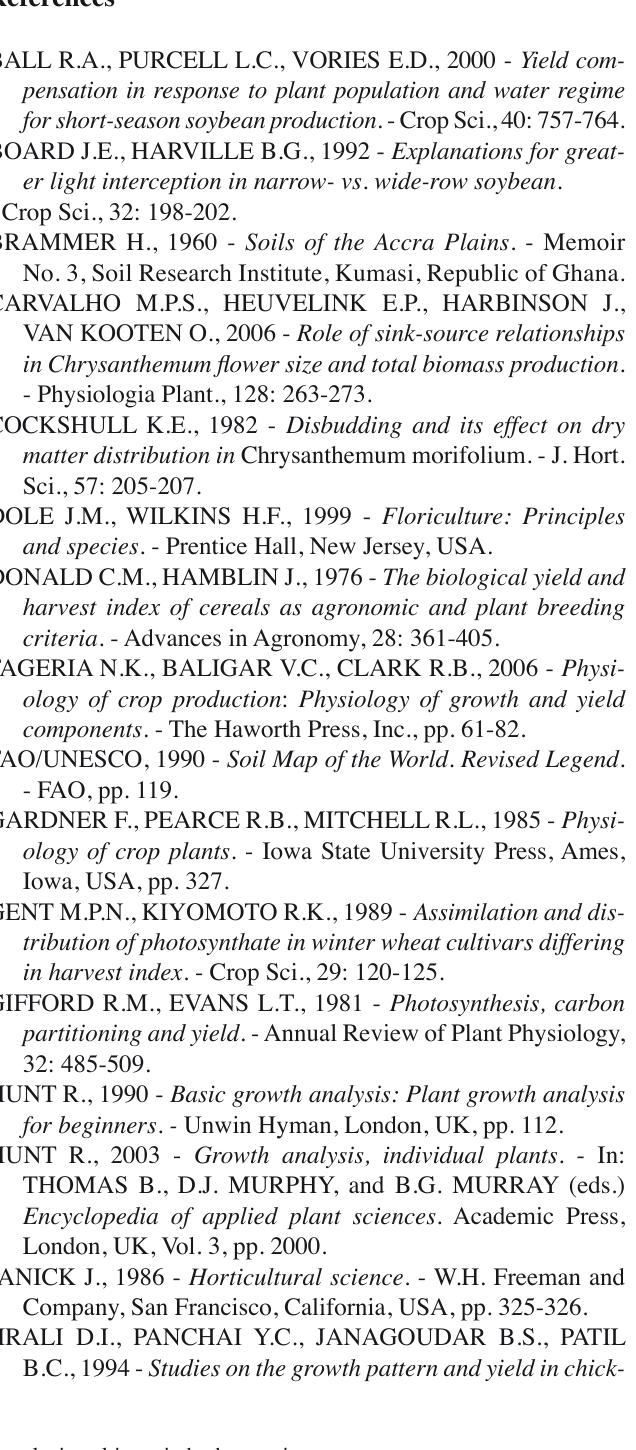
Table 4 - The effects of cultivar and disbudding on mean harvest index of two celosia cultivars in both experiments